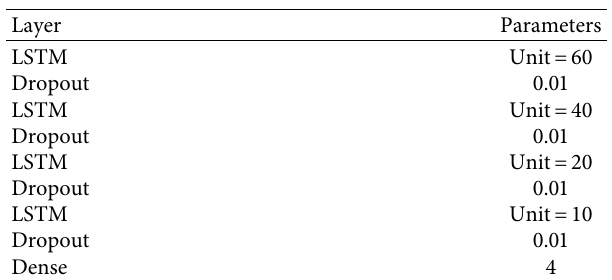
Table 5: LSTM parameters’ setting.